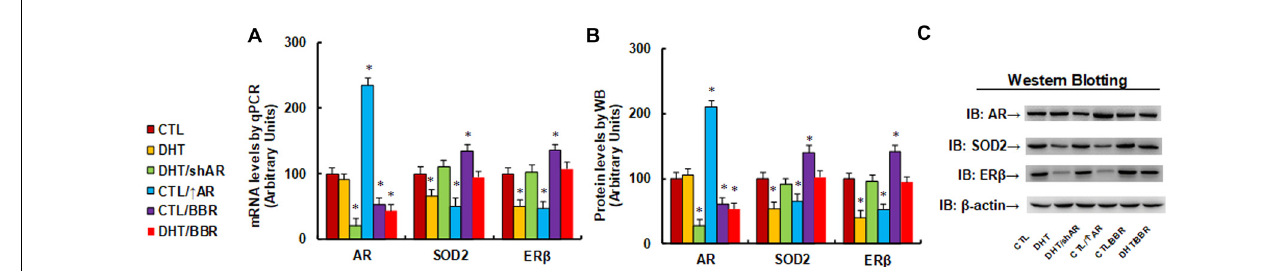
FIGURE 1 | Berberine (BBR) restores dihydrotestosterone (DHT)-mediated estrogen receptor β /superoxide dismutase 2 (ERb/SOD2)/SOD2 suppression by androgen receptor (AR) suppression in human neurons. The human ACS-5003 neurons were treated by control (CTL), DHT (10 nM), DHT with AR knockdown by lentivirus (DHT/shAR), CTL with AR overexpression by lentivirus (CTL/ ↑ AR), CTL with 10 µ M BBR (CTL/BBR), or DHT with BBR (DHT/BBR) for 24 h, then the cells were harvested for further analysis. (A) mRNA levels for AR, ER β and SOD2 by qPCR, n = 4. (B) Quantitation of protein levels, n = 5. (C) Representative western blotting pictures for (B) . ∗ P < 0.05, vs. CTL group. Data were expressed as mean ± SEM.